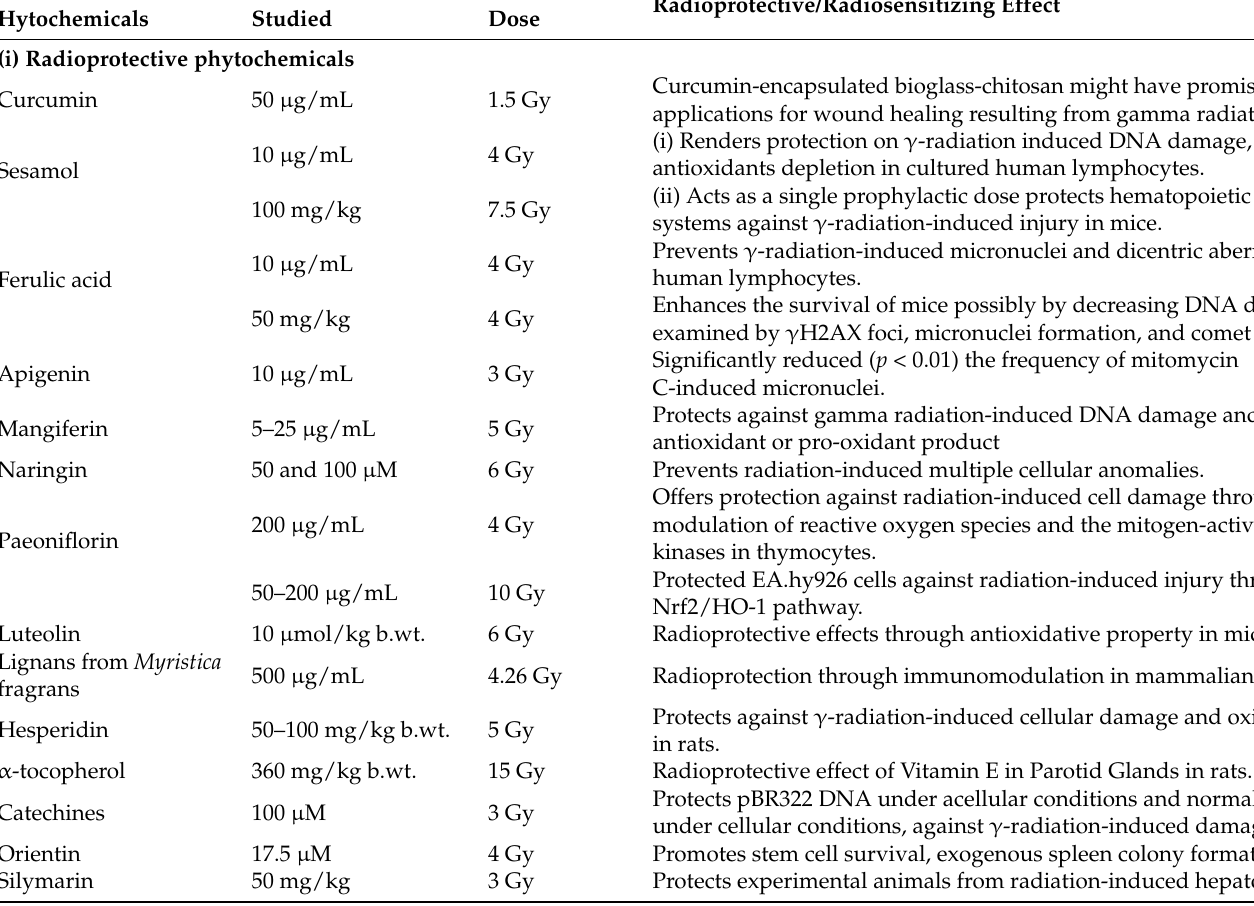
Table 4. South Asian medicinal compounds protect normal cells from radiation effects and sensitize cancer cells to radiation effects. South Asian medicinal compounds at the concentration studied protects the normal human cells and experimental animals against indicated radiation dose and sensitizes radiation effects in the cancer cells through different